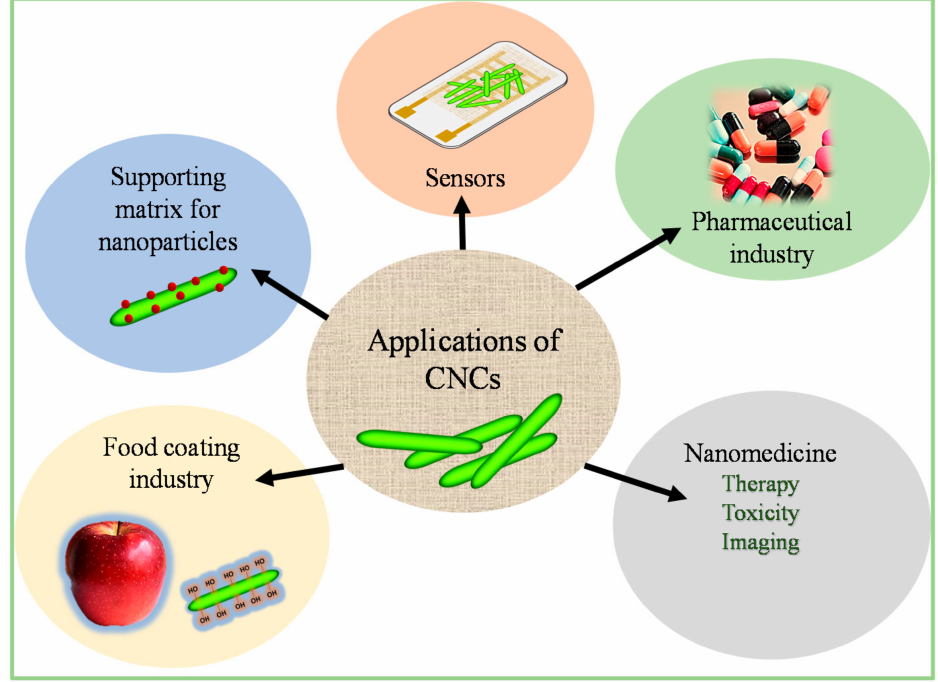
Figure 5. Different applications for CNCs reported in the